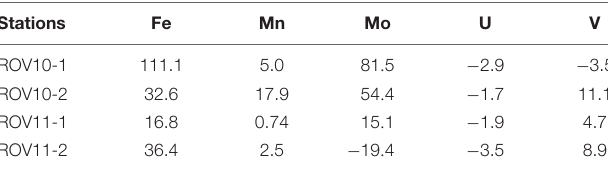
TABLE 1 | Calculated benthic fluxes of Fe, Mn, Mo, U, V from the sediments of the southern Okinawa Trough.